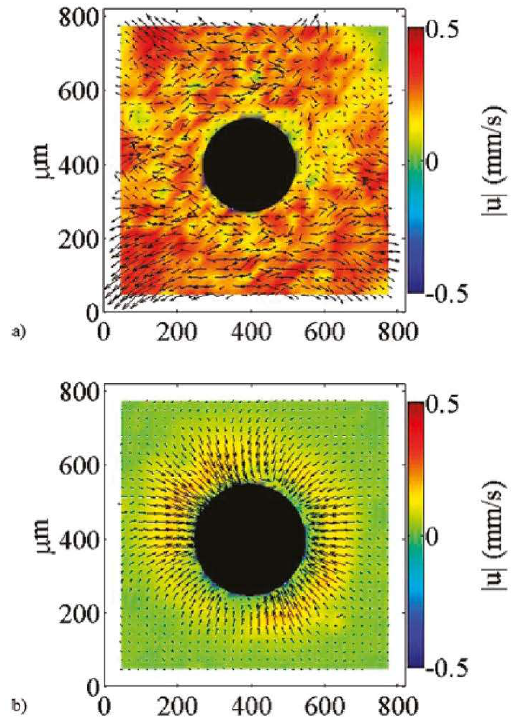
Figure 2. Particle image velocimetry (PIV) velocity fields for ( a ) cavitation bubble with surface oscillations resulting an observed chaotic flow and ( b ) without surface oscillations and ordered flow. Reproduced with permission from [29].